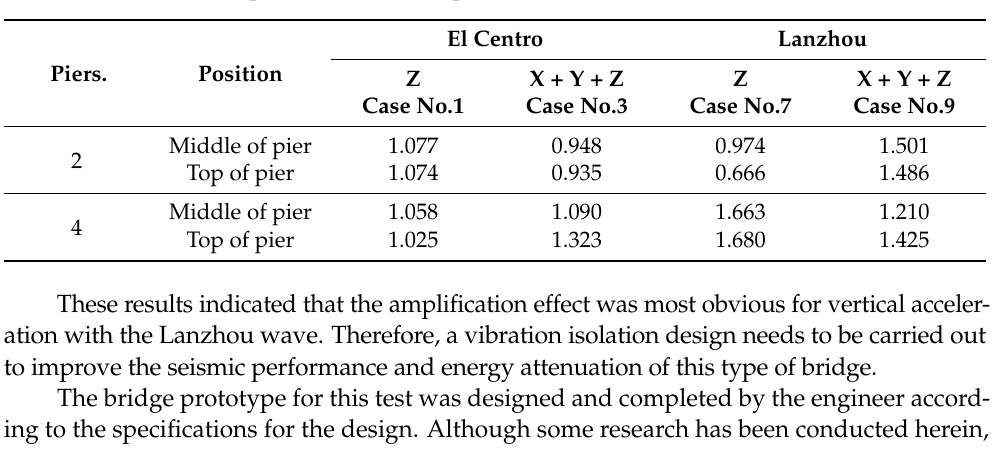
Table 9. Acceleration amplification factors of